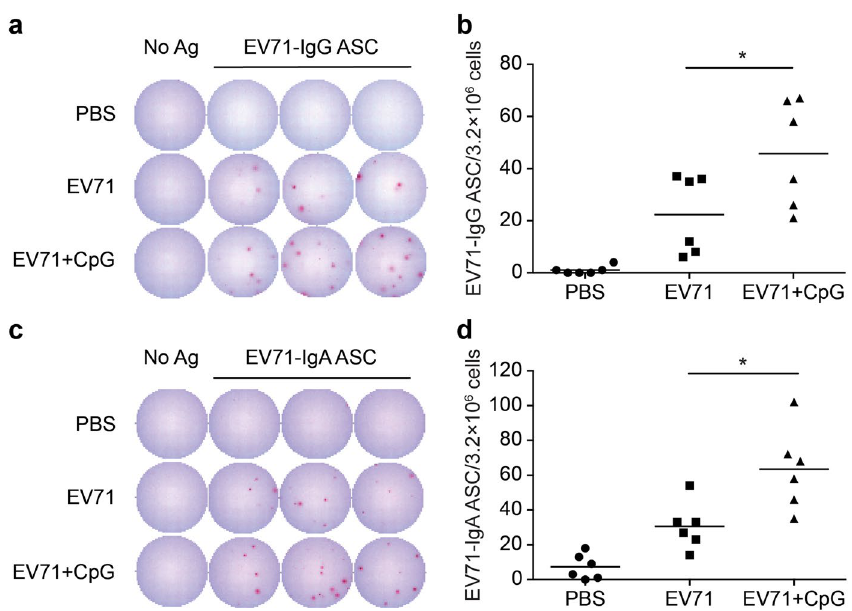
Figure 5. EV71-specific IgG antibody-secreting cells (ASCs) and IgA ASCs in mouse spleens. Mice were intranasally immunised with PBS or formalin-inactivated EV71 without/with CpG three times at 3-week intervals. Spleens were isolated at 2 weeks after the third immunisation, and the collected samples were used in EV71-specific ELISPOT assays to determine the numbers of IgG ASCs ( a , b ) and IgA ASCs ( c , d ). Values shown are means ± SEMs of six mice in each experimental group; * p < 0.05. One representative study of three with similar results is